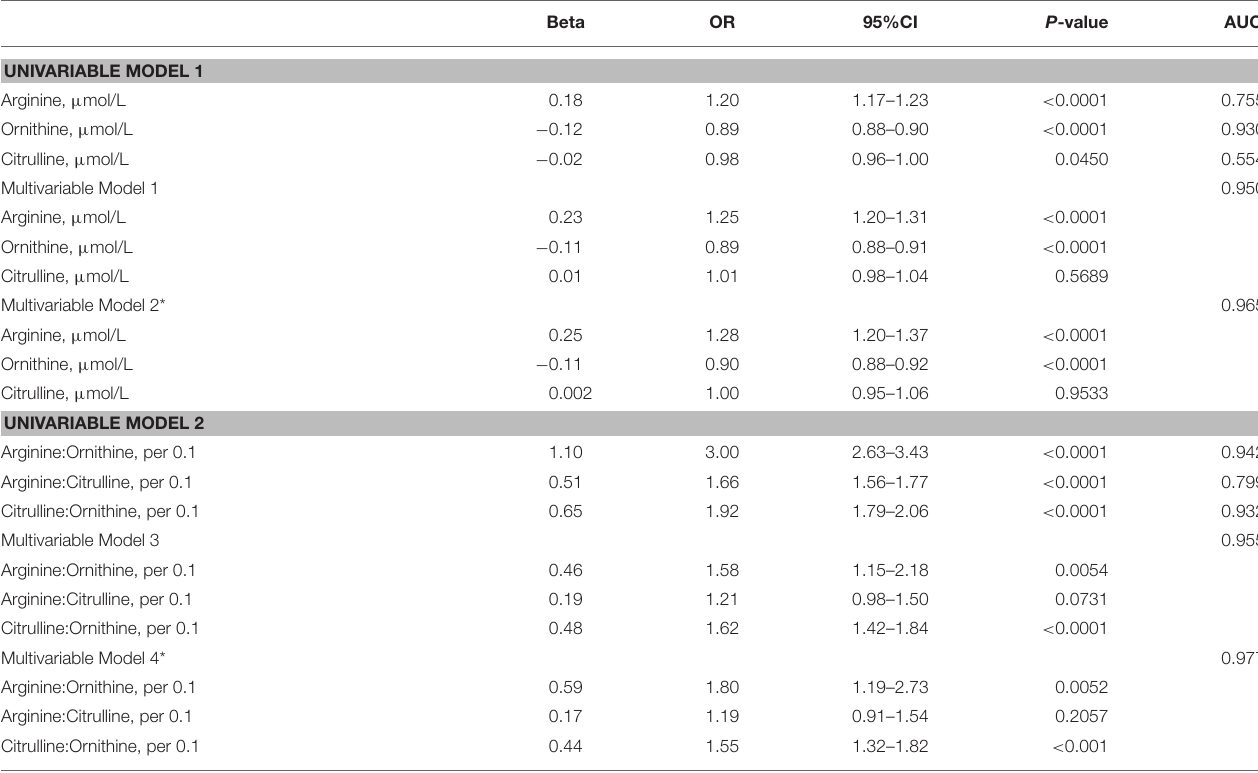
TABLE 3 | Odds ratio of amino acids and ratios of amino acids for the risk of type 2 diabetes mellitus after exclusion of patients with diabetic complications. Beta OR 95%CI P -value